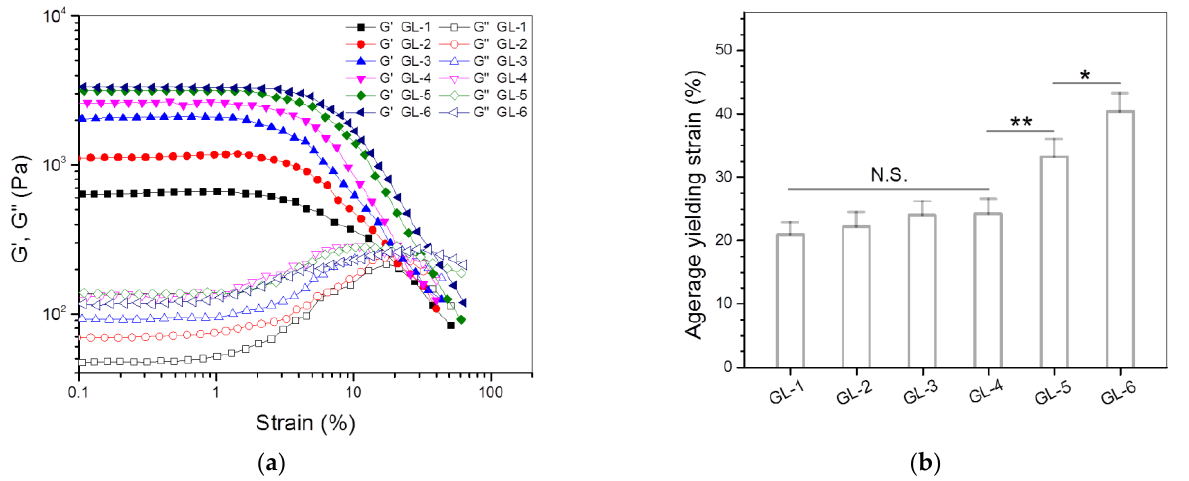
Figure 5. Strain sweep spectra ( a ) and average yielding strain ( b ) for gels illustrated in Table 2 ( * , p < 0.05; ** , p < 0.01; N.S., not significant).